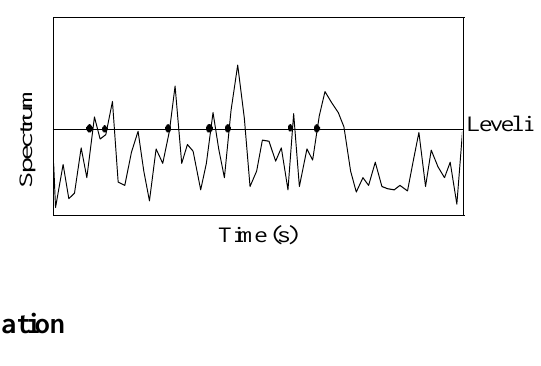
Figure 1. Frequency of crossing over level